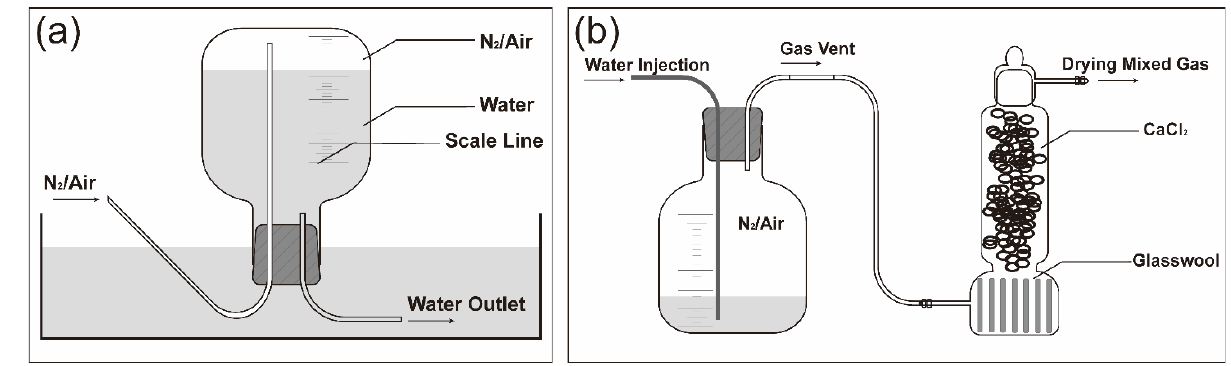
Figure 4. Nitrogen ratio regulating device: ( a ) gas collecting; ( b ) improved air delivery connection device.